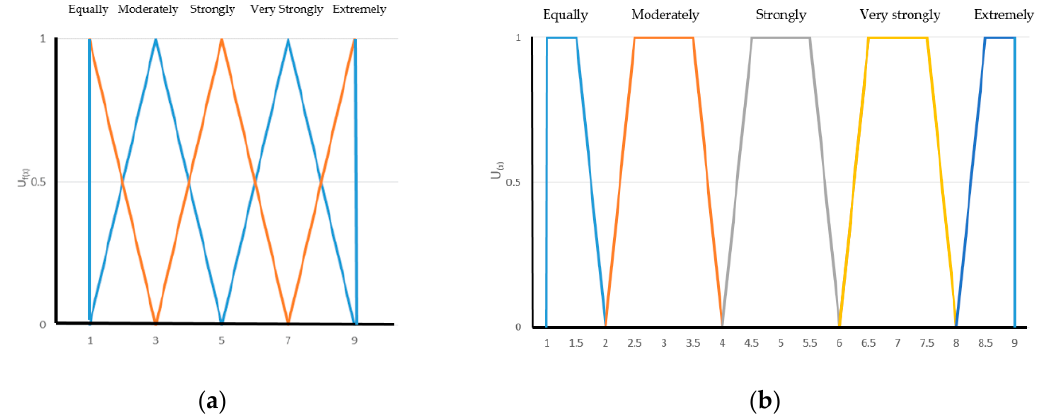
Figure 2. Graph to show trinangular fuzzy numbers ( a ) and trapezoidal fuzzy numbers ( b ) corresponding to linguistic varaibles representing levels of prefernece.